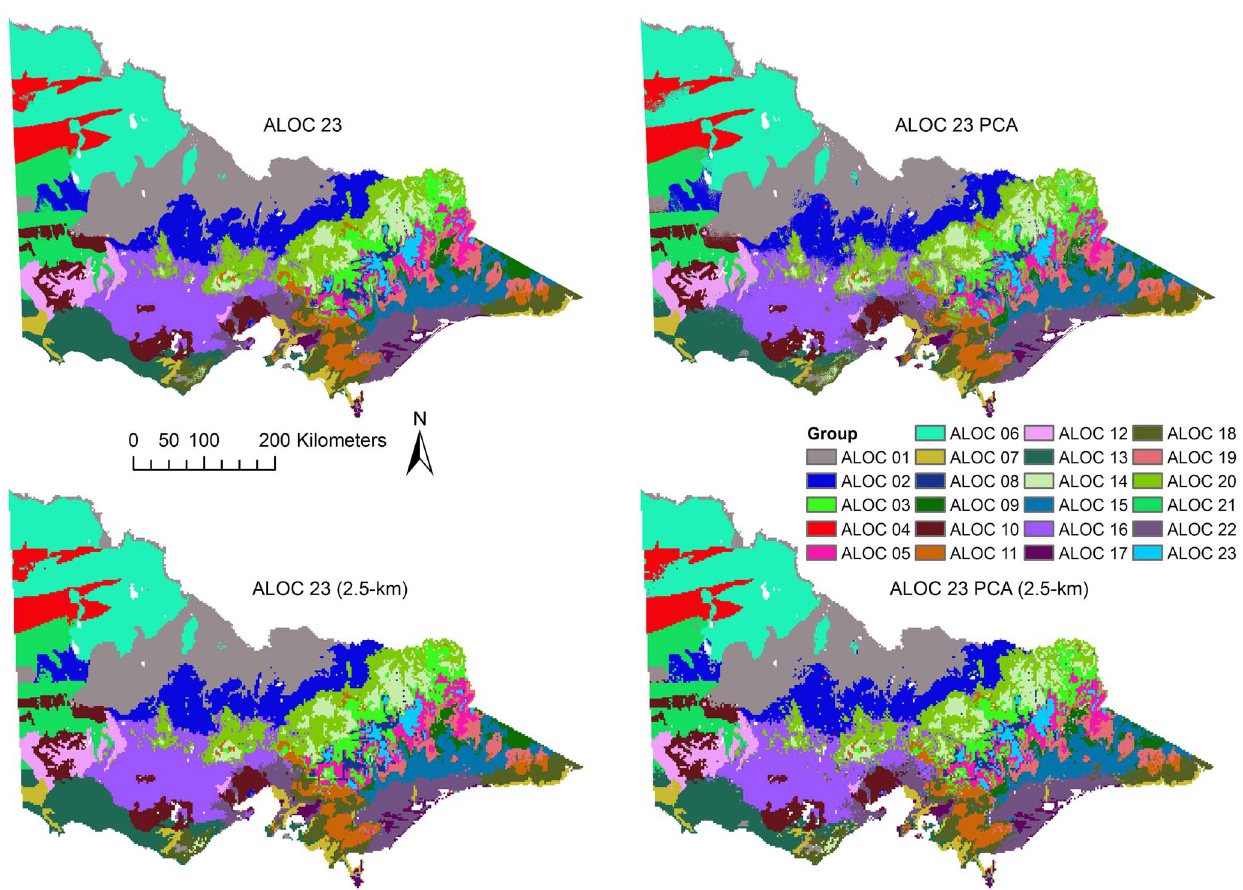
Figure 5. Results of the ALOC 23 (30 m) classifications. Top row - ALOC 23 and ALOC 23 PCA; Bottom row - ALOC 23 and ALOC 23 PCA resampled to 2.5 km. Colours represent each of the ALOC non-hierarchical clusters. Similar colours and cluster numbers do not necessarily represent related groups.